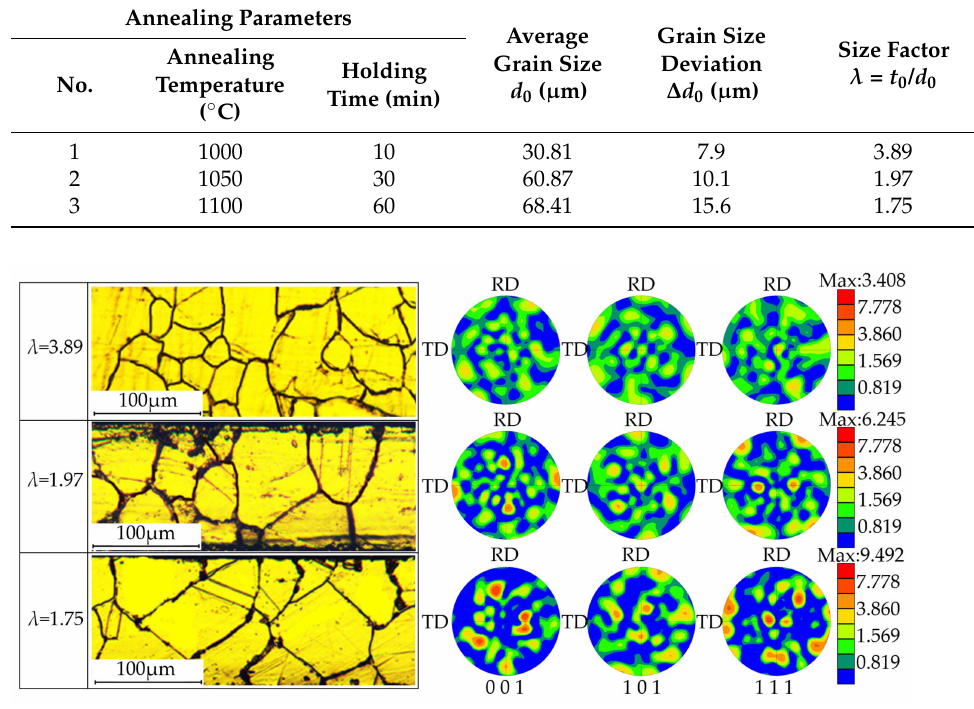
Table 1. Annealing parameters of SUS304 foils [8].